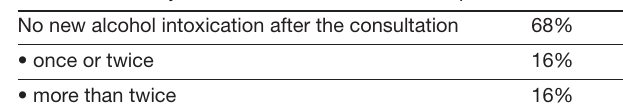
Table 2: summary of items about alcohol